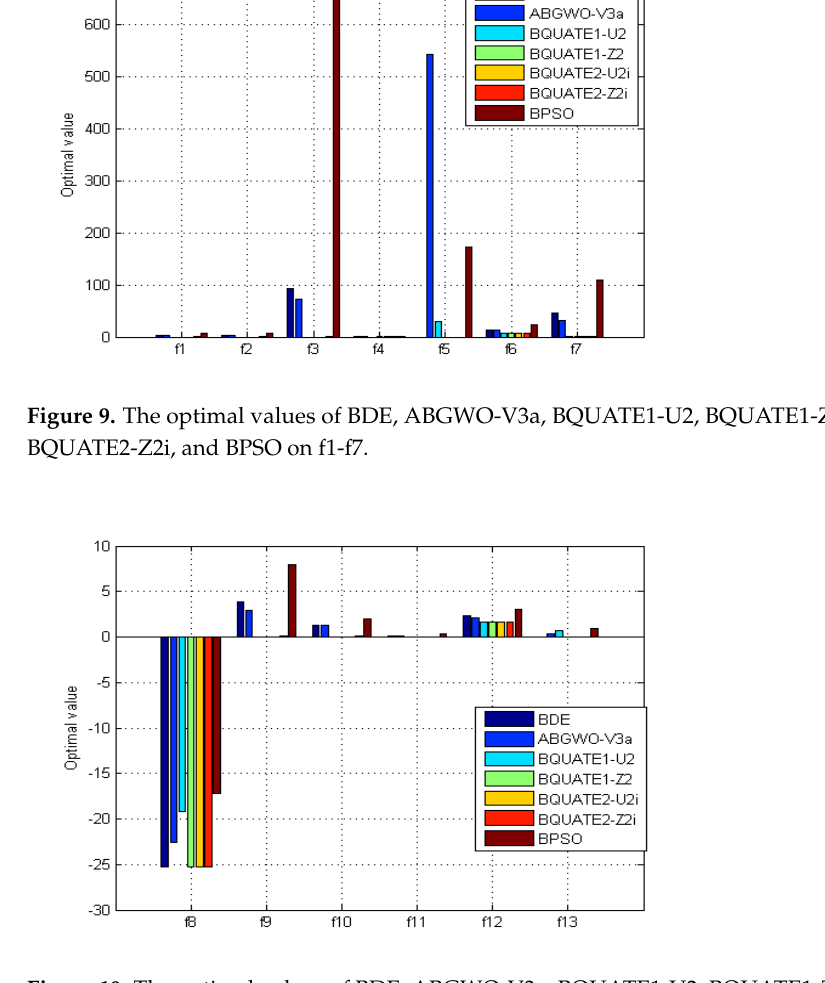
Figure 10. The optimal values of BDE, ABGWO-V3a, BQUATE1-U2, BQUATE1-Z2, BQUATE2-U2i, BQUATE2-Z2i, and BPSO on f8-f13.